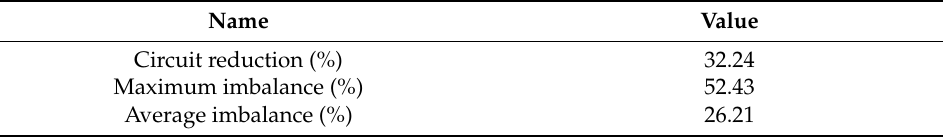
Table 2. Partition statistics for Circuit 5 feeder, two zones.